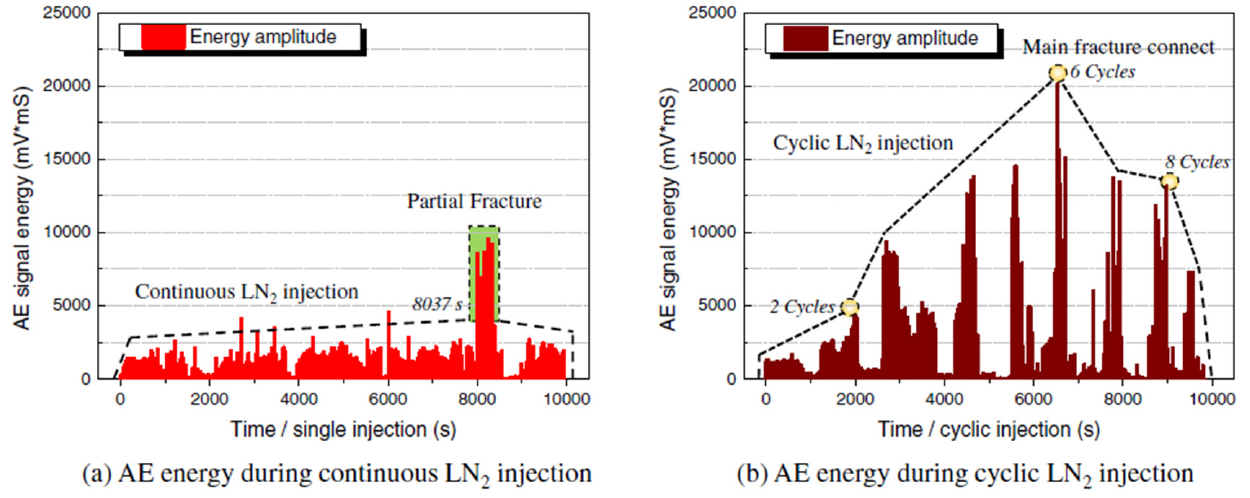
Figure 4. Changes in acoustic emission energy with time during the injection of LN 2. Cong et al. (2021) [56] examined variations in the temperature field and strain field of coal around the drill hole after the injection of LN 2 into the drill hole. Upon heat- ing from − 30 ◦ C to 30 ◦ C, the expansion capacity augmented slowly until it leveled off.